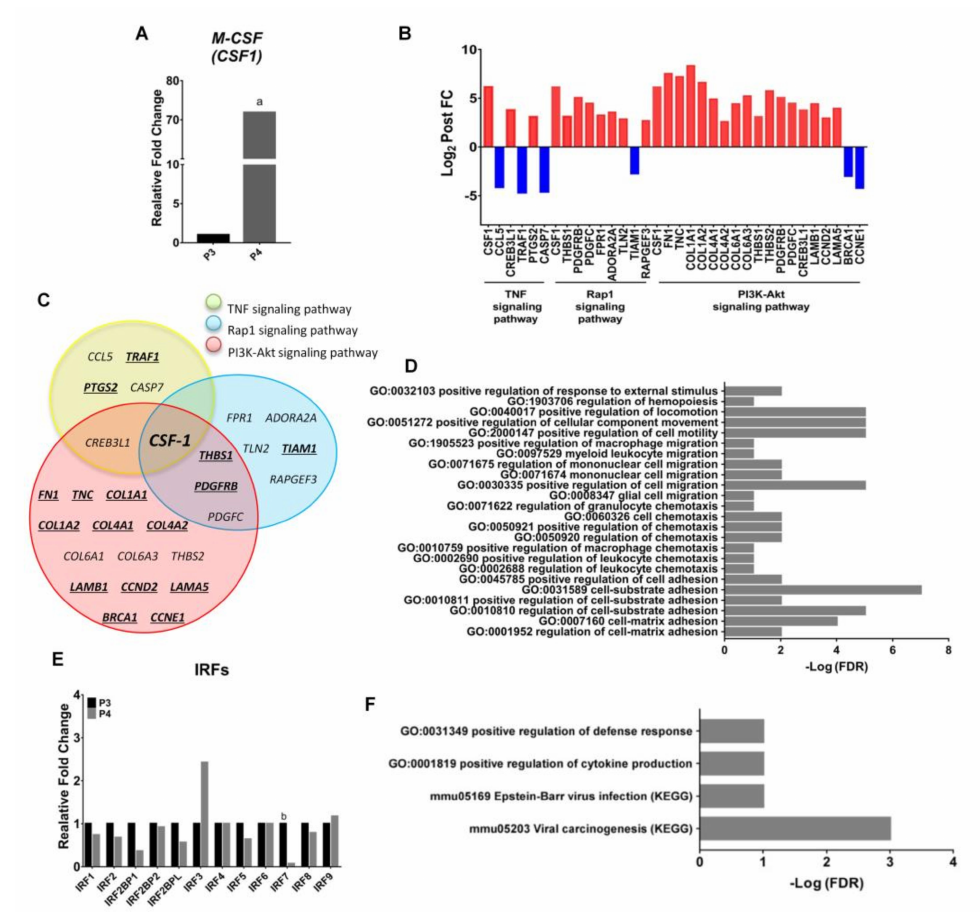
Figure 6. Transcriptome analysis of M2 macrophages from P4 modulated by endogenous CSF-1 reactivation and gene reprograming. ( A ) Fold change of M-CSF ( CSF-1 ) in P4 compared to P3. ( B ) KEGG pathway enrichments of selected DEGs in P4 compared with P3 (blue: downregulated genes; red: upregulated genes). ( C ) Venn diagram of three KEGG pathways were highly associated with endogenous CSF-1 expression. The yellow circle represents the DEGs in TNF pathway, the blue circle represents the DEGs in Rap1 pathway and the red circle represents the DEGs in PI3k-Akt pathway. The overlapping areas indicate the shared genes of any two or three groups. ( D ) Bar plot of selected DEGs were related with CSF-1 expression in P4 compared with P3. ( E ) Expression of IRFs family gene in P4 compared with P3. ( F ) Bar plot of selected DEGs were related with IRF7 expression in P4 compared with P3. n = 5, a, p < 0.05 when compared with P3; b, p < 0.05 when compared with